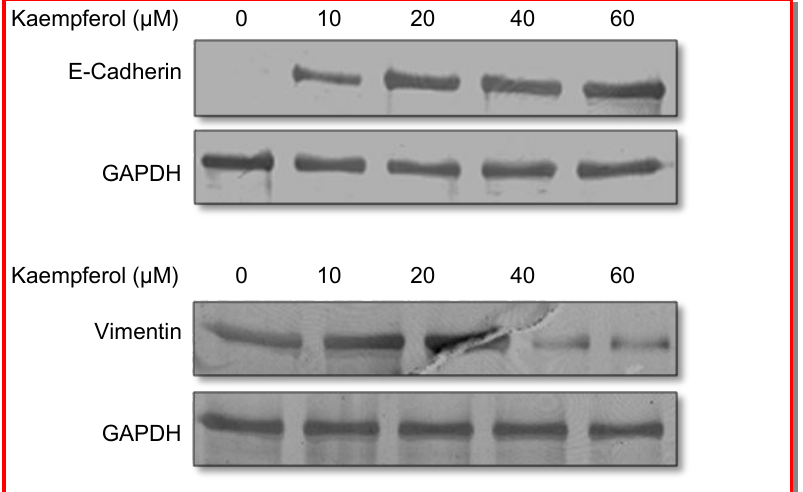
Figure 2: Effects of kaempferol on the expression of EMT markers in non-small cell lung cancer cells. A549 cells were treated with increasing concentrations of kaempferol for 24 hours and the protein expression levels of E-cadherin and vimentin were detected